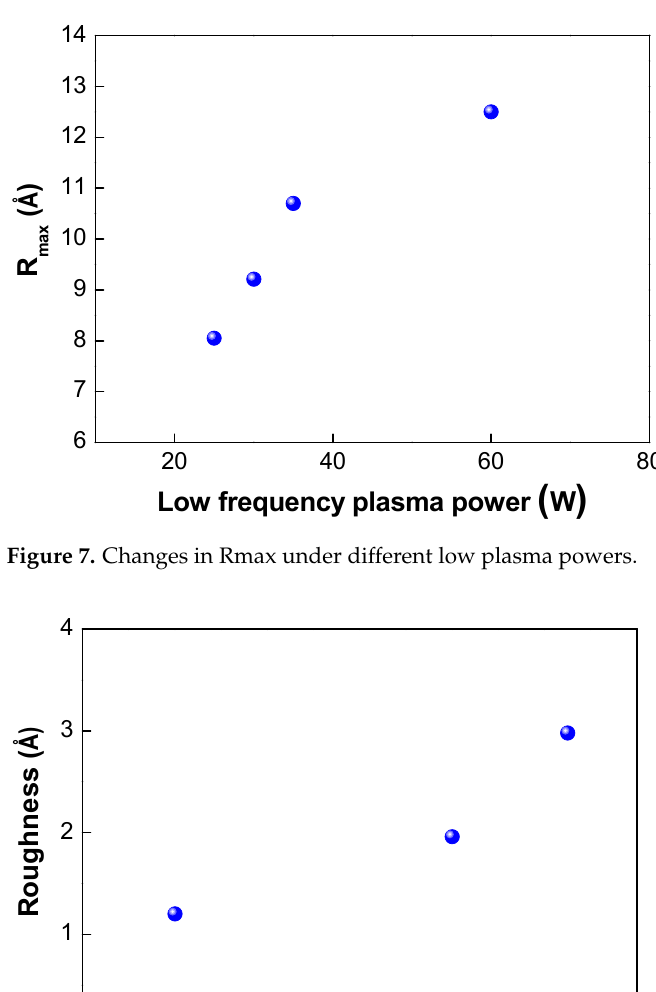
Figure 6. Changes in bonding strength when low frequency plasma power was increased.